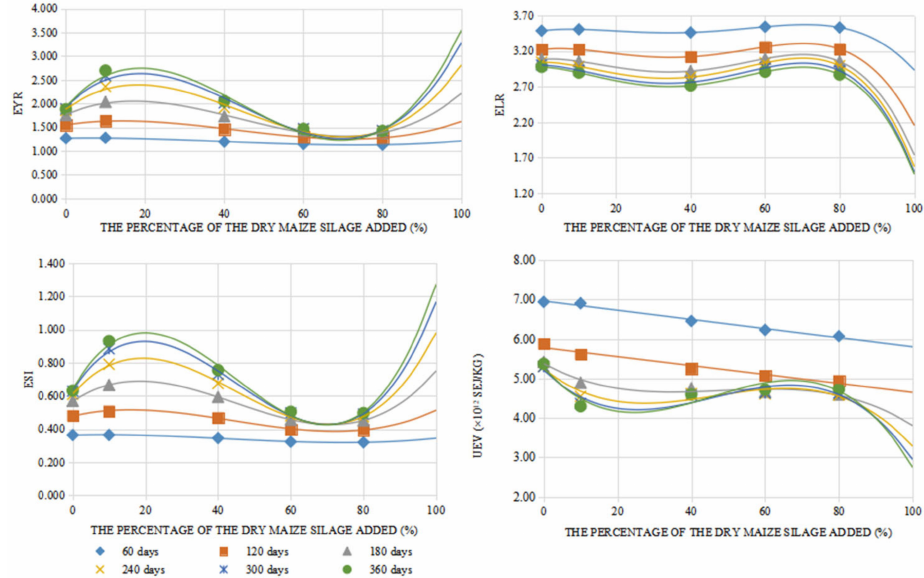
Figure 8. Predicted change trends of main indices with different percentages of maize